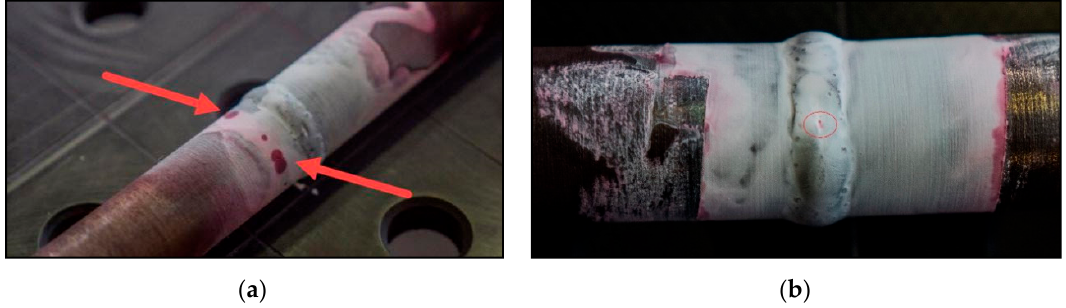
Figure 7. ( a ) Welded joint No. 3, defects indicated by penetrant test; ( b ) crater crack on welded joint No. 1